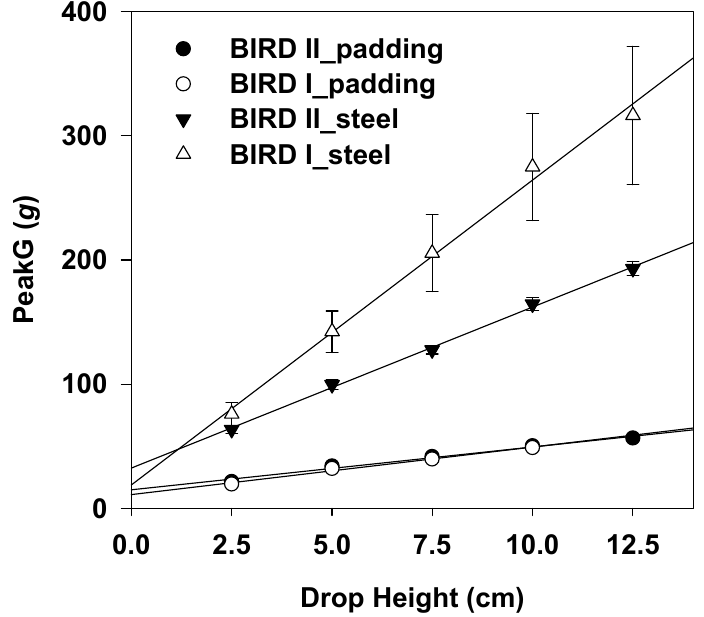
Figure 14. Mean peakG measured by BIRD I and II at different drop heights on two contacting